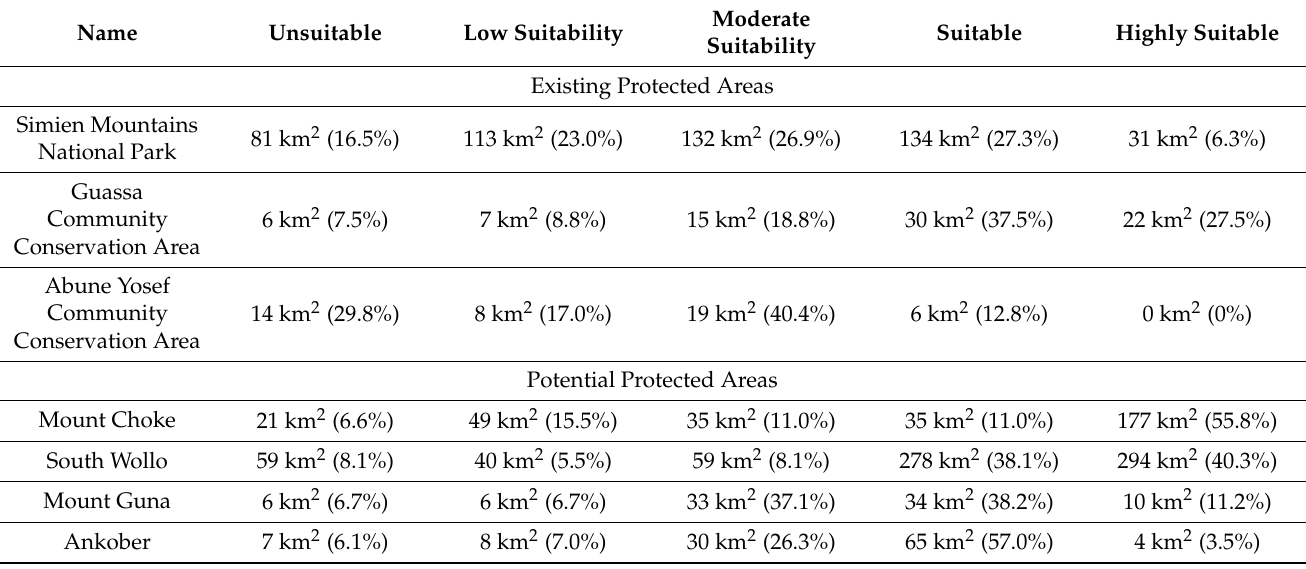
Table 2. Three existing protected areas and four proposed protected areas, describing the land area that falls within each class of suitable guassa grass habitat and what percent of the protected area that